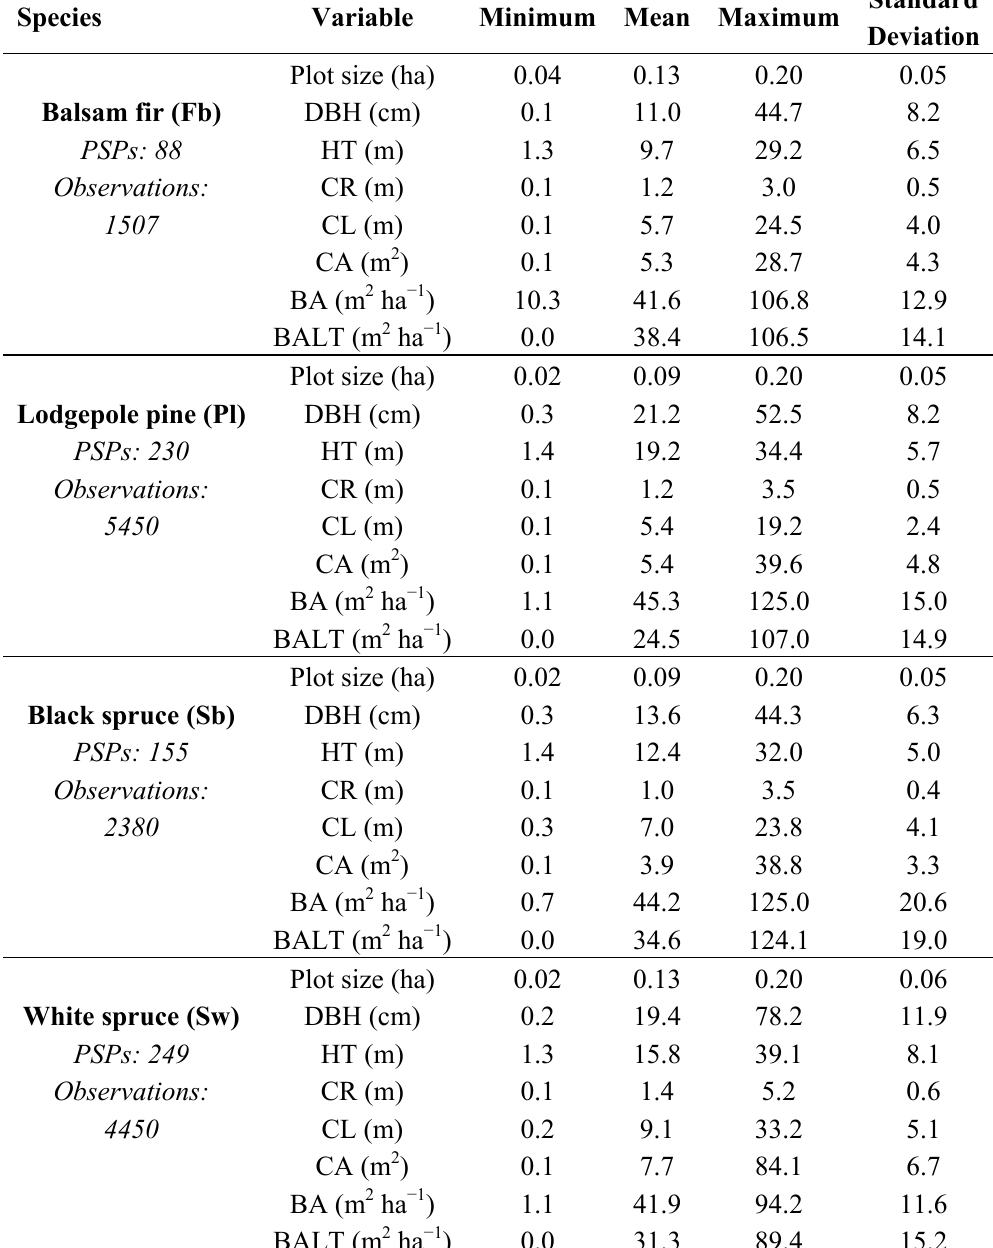
Table 2. Basic statistical information of selected variables for each conifer species.